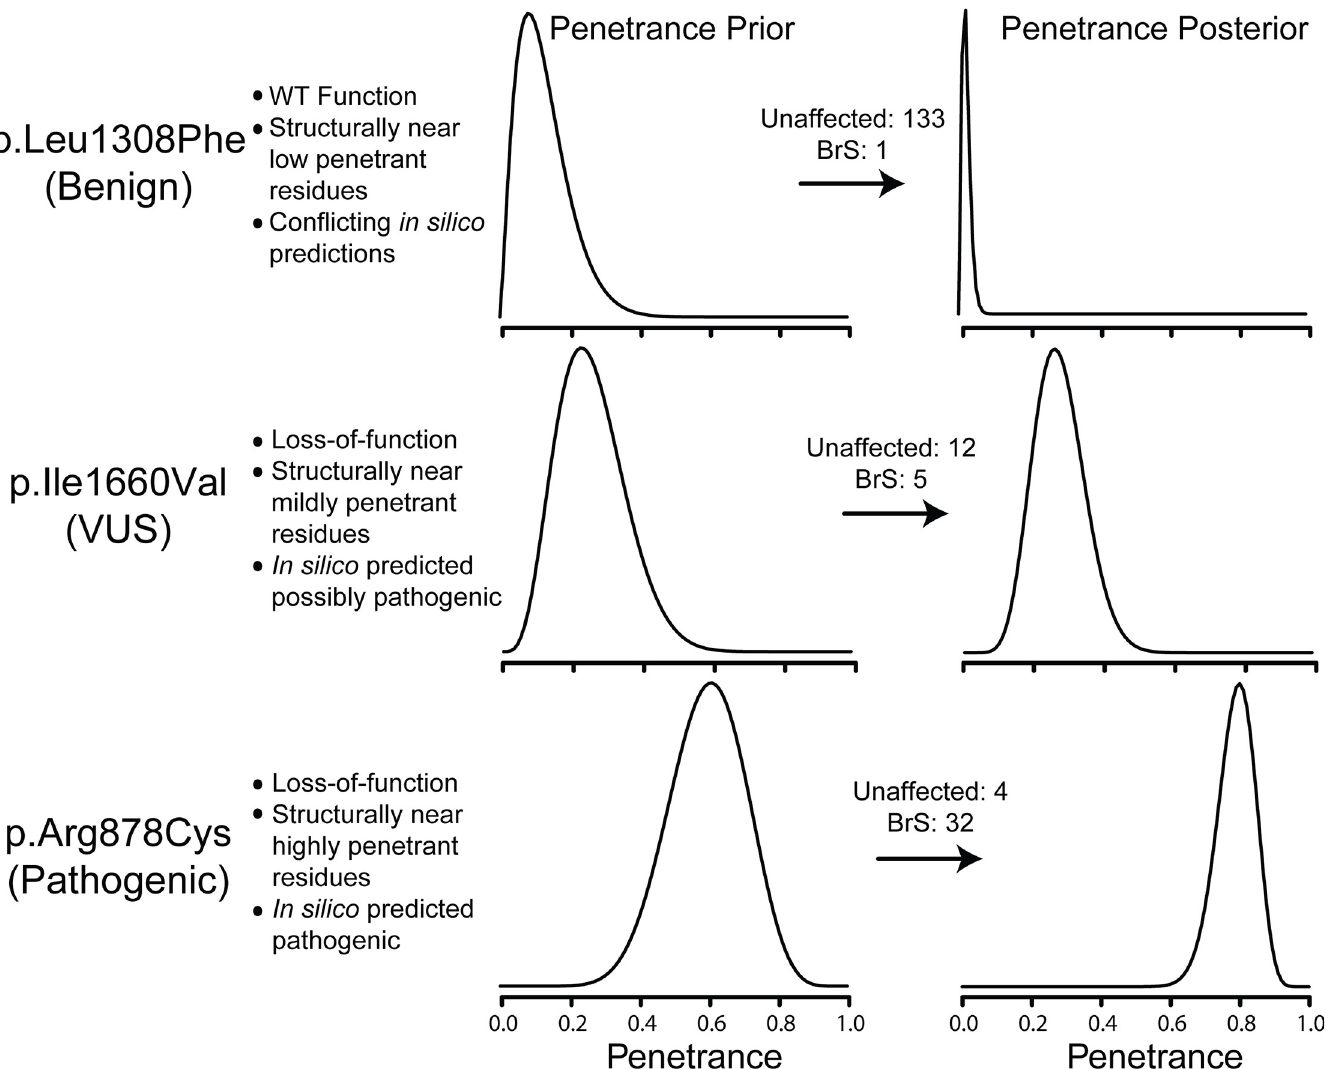
Fig 1. Penetrance priors are informed by variant-specific features. Probability density (y-axis) versus penetrance (x-axis) for three selected SCN5A variants where peak current, penetrance density, and in silico classification are known. Numbers of affected and unaffected individuals reported are presented for each variant. Penetrance priors are low for c.3922C > T (p.Leu1308Phe; Benign according to ClinVar), moderate for c.4978A > G (p.Ile1660Val; VUS), and higher for c.2632C > T (p. Arg878Cys; Pathogenic). When variant-specific data are known, the penetrance estimate is adjusted to reflect the penetrance probability consistent with variants with similar